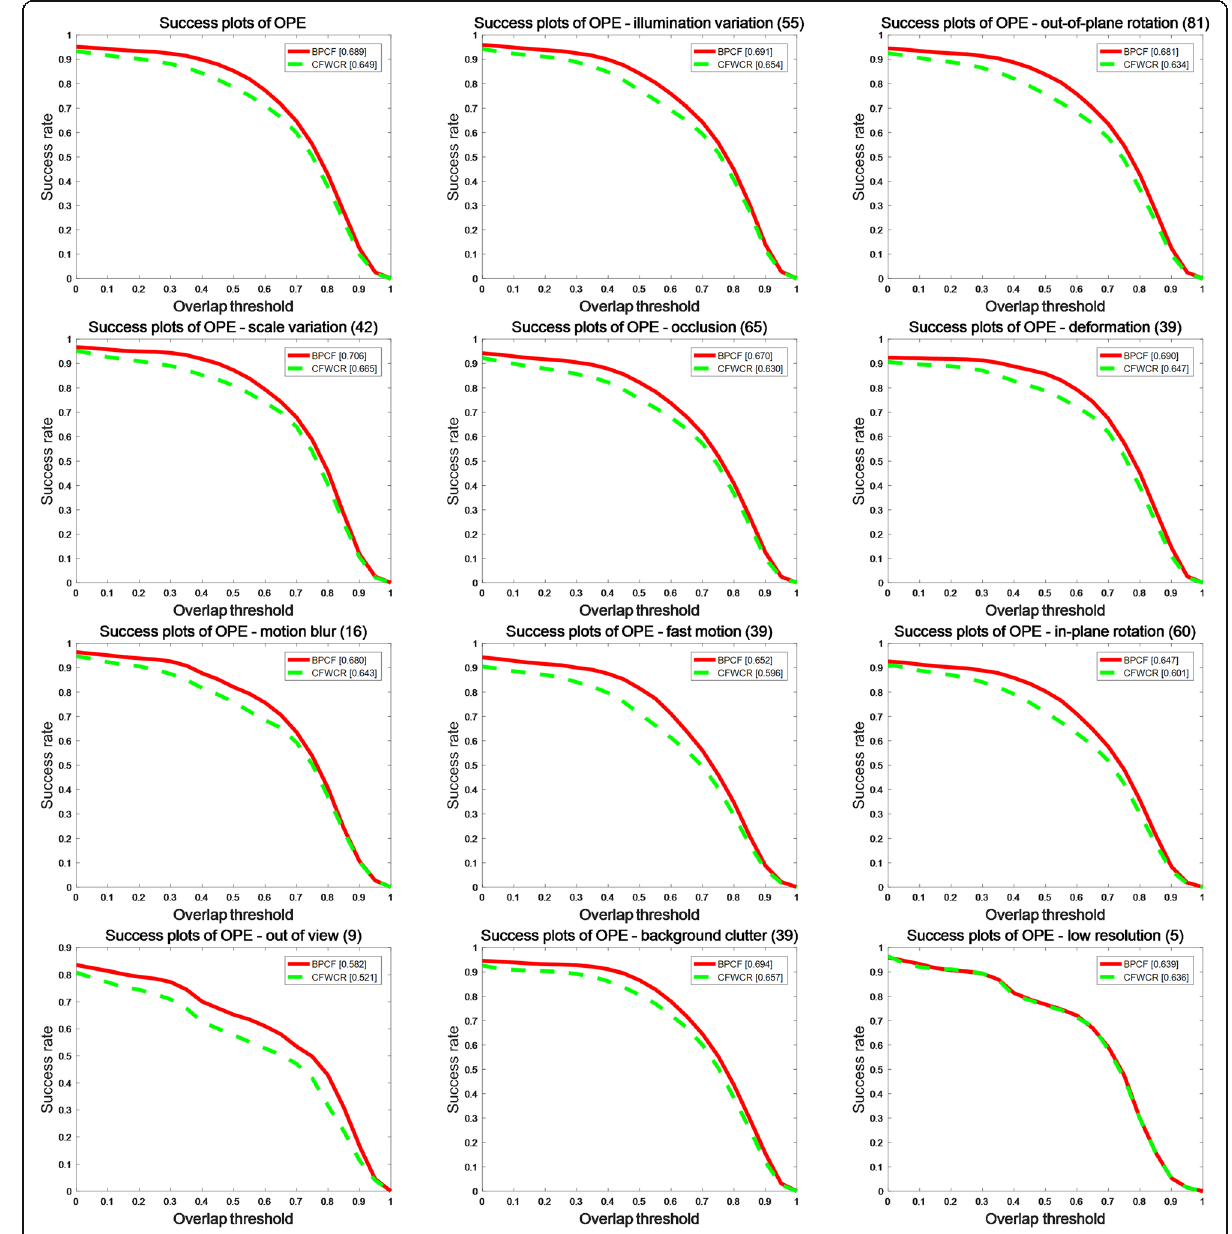
Fig. 4 Baseline comparison. Success plot of OPE on OTB-2015 benchmark. The red line denotes BPCF with background perception regulation term and the self-adaptive model update strategy jointly. The green line denotes CFWCR